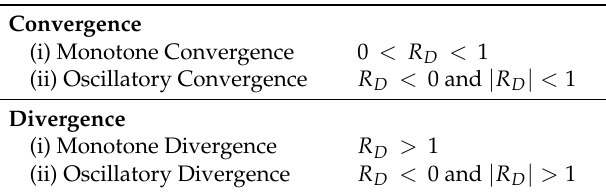
Table A1. Convergence types based on the discrimination ratio R D .